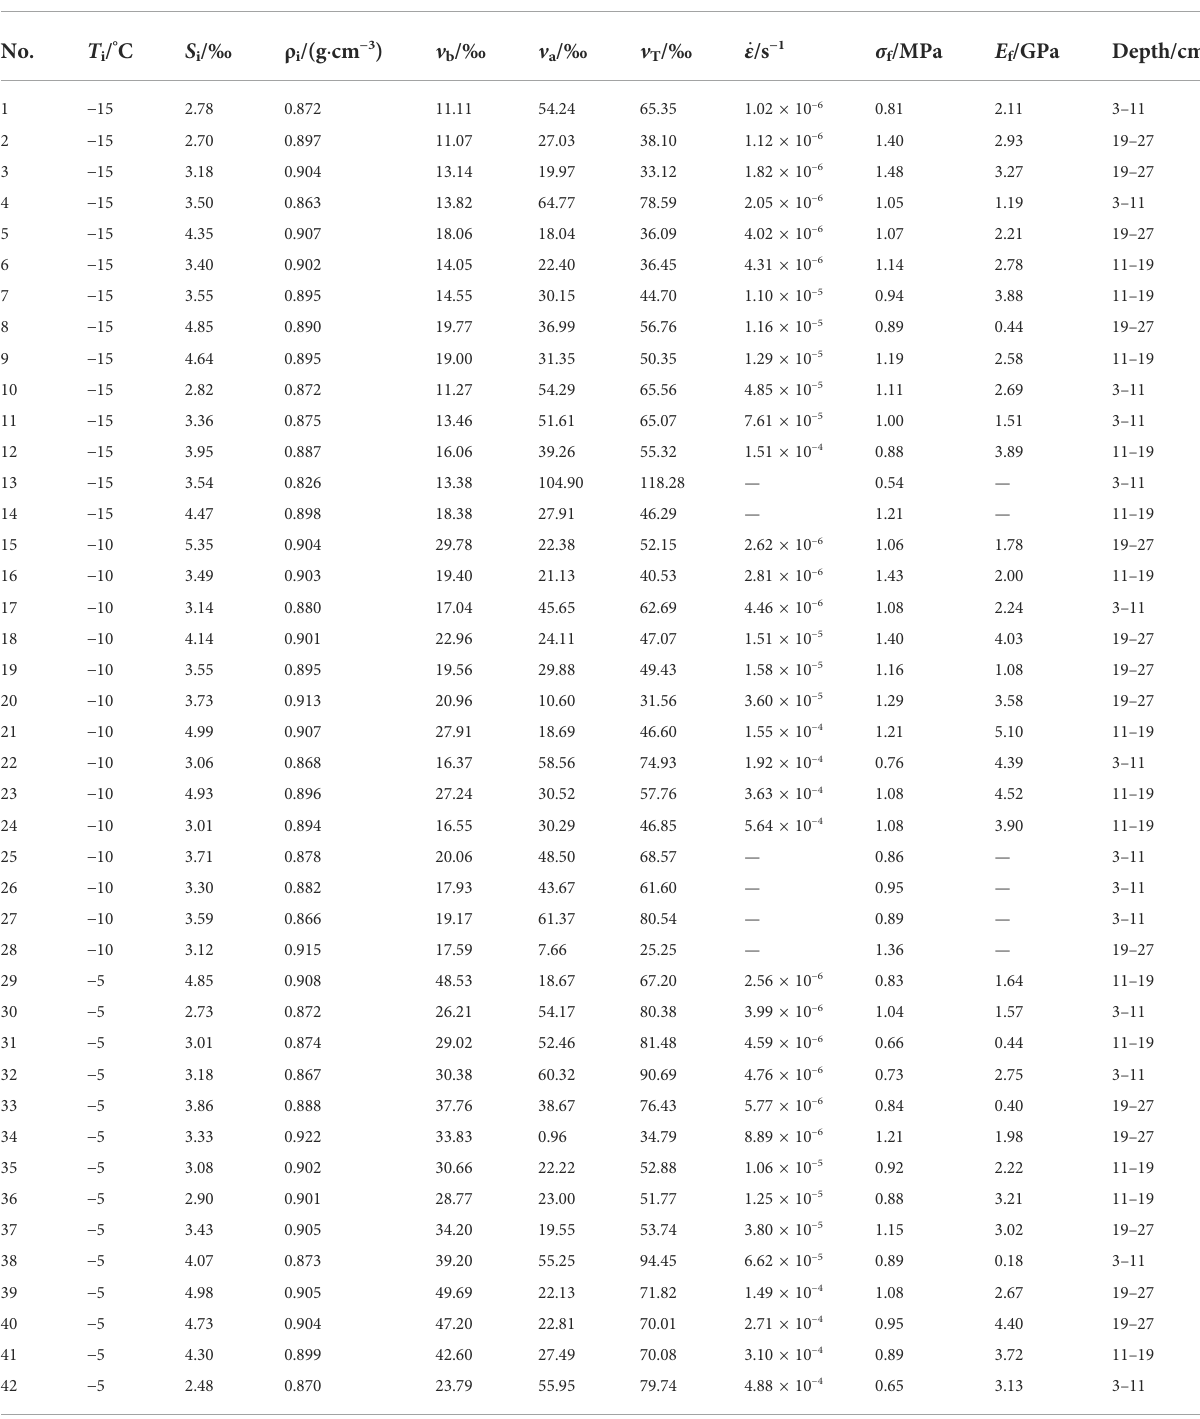
TABLE 2 Detailed data for all beams and test